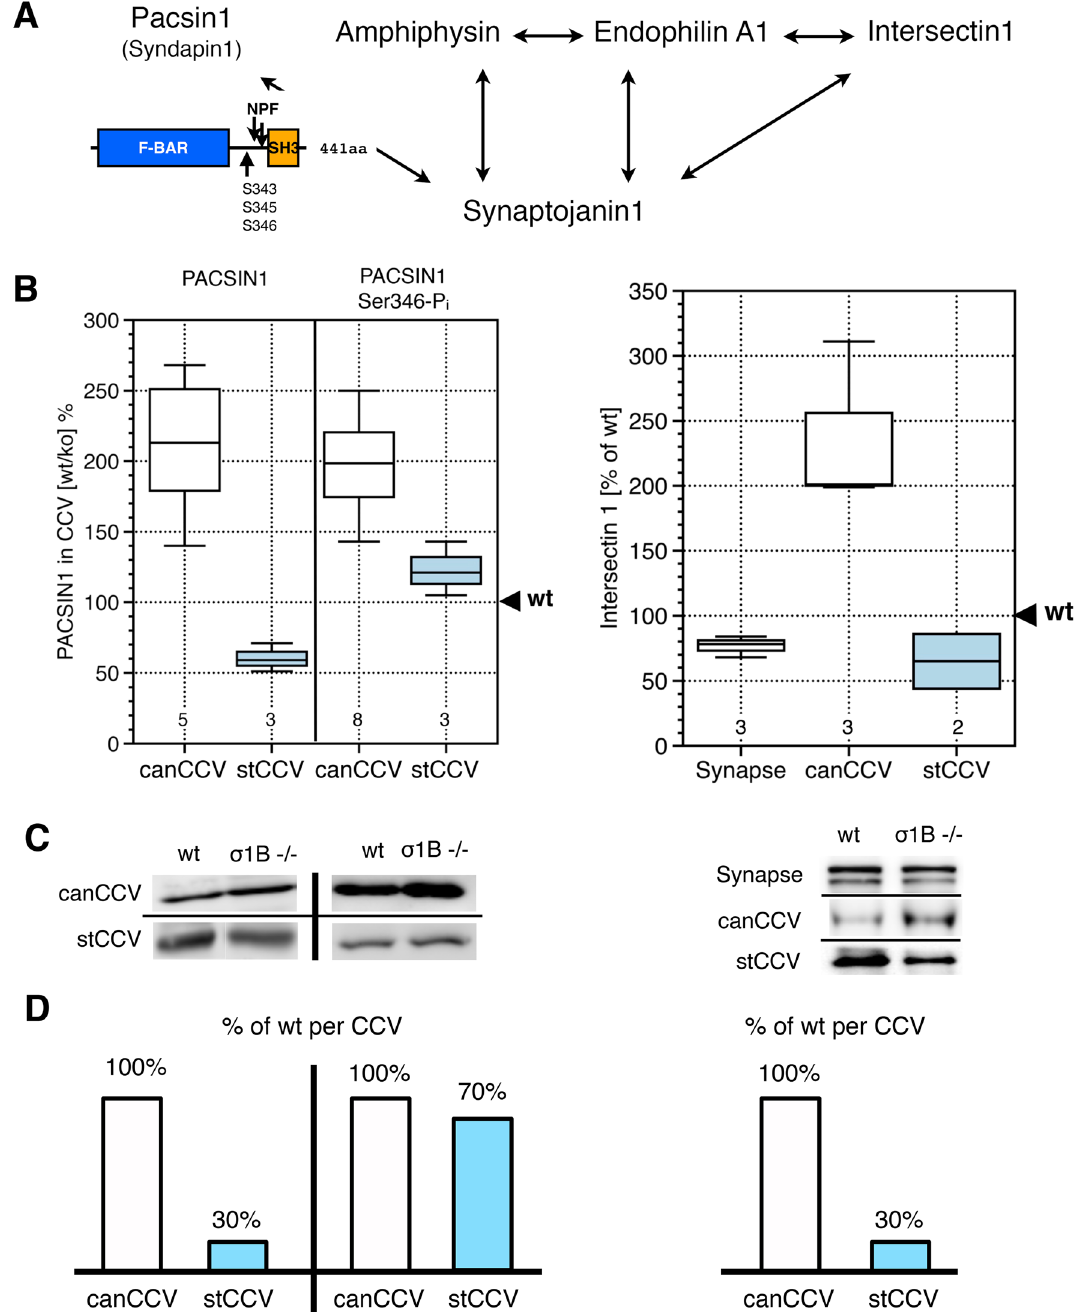
Figure 3. Pacsin1, activated pacsin1 (Ser346-Pi) and ITSN1 wt versus ko synaptic and CCV levels. ( A ) Protein– Protein interaction scheme of these synaptojanin1 binders. ( B ) Comparison of pacsin1, phosphorylated and activated pacsin1 and ITSN1 levels between synaptic AP2 CCV from wt and AP1/σ1B ko mice. Values from wt samples are defined as 100% and values from ko samples are expressed relative to wt. Numbers in box-blot diagrams indicate the number of independent biological samples. ( C ) Representative western-blot data used for the box-blot diagram (see “Materials and methods” section for details) Pacsin1, 52 kDa band; Pacsin1 Ser346-Pi, 52 kDa band; ITNS1, 200 kDa band;. ( D ) Bar scheme below indicates changes in protein levels per